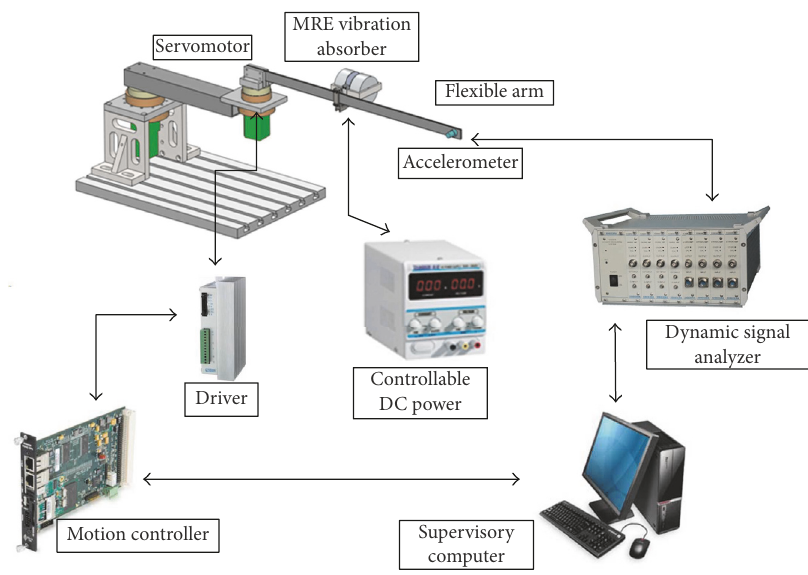
Figure 17: Scheme of the experimental setup.